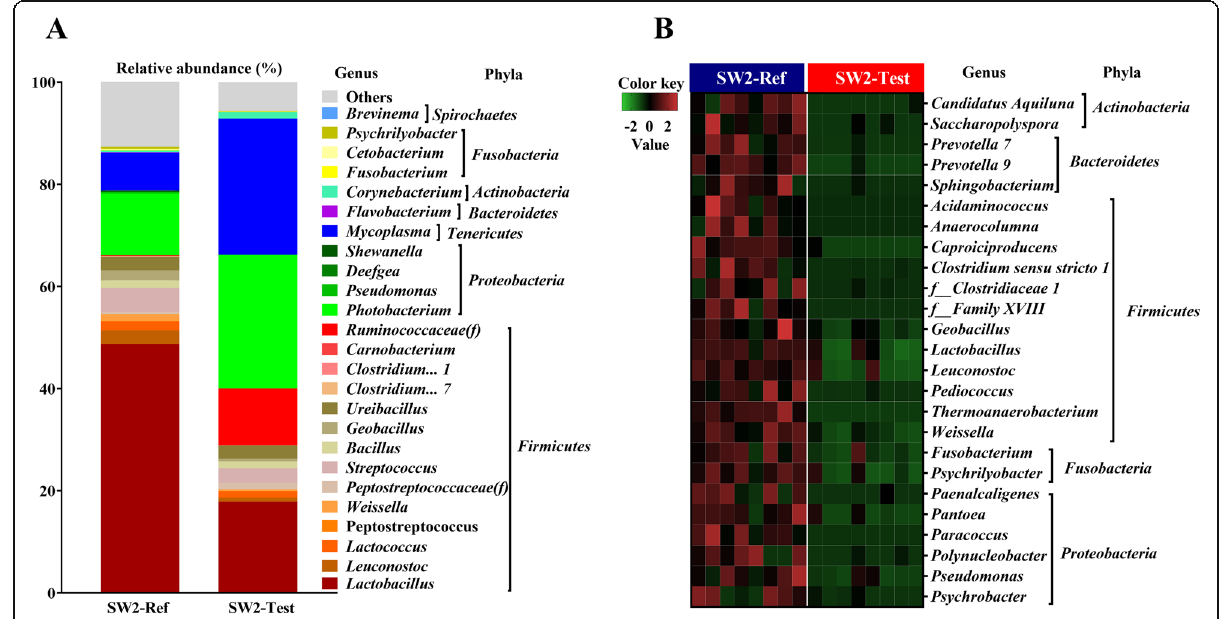
Fig. 4 The effect of dietary functional ingredients on microbiota in digesta from the distal intestine of Atlantic salmon at SW2. a Mean relative abundance (Top 25) of each taxon at genus level in fish at SW2 fed Ref and Test diets. The top 25 genera were selected accounted for more than 80% of the total abundance in each treatment. b The heatmap of bacterial abundance at SW2 based on MaAsLin 2 analysis. Rows depict results for 25 bacteria ( q-value < 0.05), columns depict the results from the 8 samples from fish fed each of the two diets. Colors correspond with normalized relative abundances, i.e., red (high positive value) indicates the maximum relative abundance; Green (low negative value) indicates the minimum relative abundance. f__: